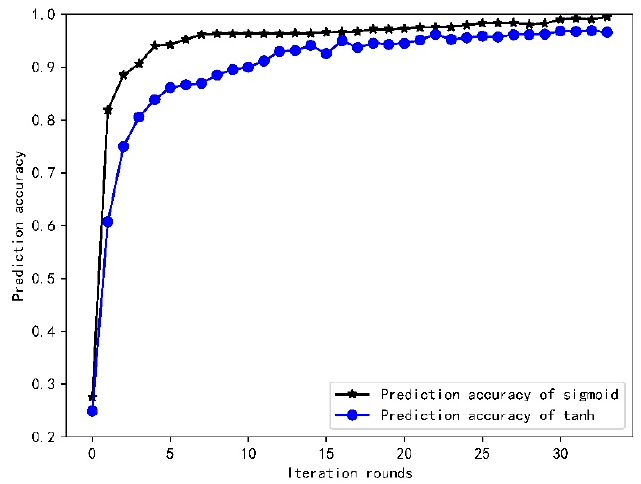
Figure 5. Prediction accuracy of the neural network. Based on prediction trajectory of vehicles in the coverage area of the RSUs, the RSUs divide vehicles into different clusters, and the CMs in a cluster must have the same next prediction lanes. For example, as shown in Figure 6, the next lanes of vehicles in the coverage area of R m may be lane 1, lane 2, lane 3, and lane 4, and the clusters can be denoted by C m , i ( i = 1, 2, 3, 4 ) . C num denotes the vehicle number in C m , i , and the next prediction lanes of V 19 , V 20 , V 21 , and V 22 are all lane 1. V 19 , V 20 , V 21 , and V 22 constitute C m ,1 , and C num m ,1 = . The cluster dividing algorithm is shown as Algorithm 1. Algorithm 1 Cluster Dividing Algorithm Based on Mobility Prediction